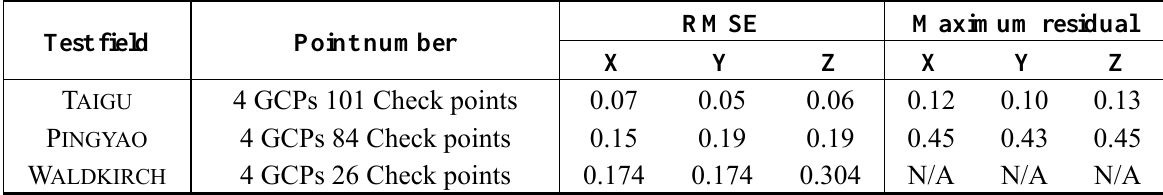
Table 4. Adjustment results from published reference papers [16,17] (Unit: